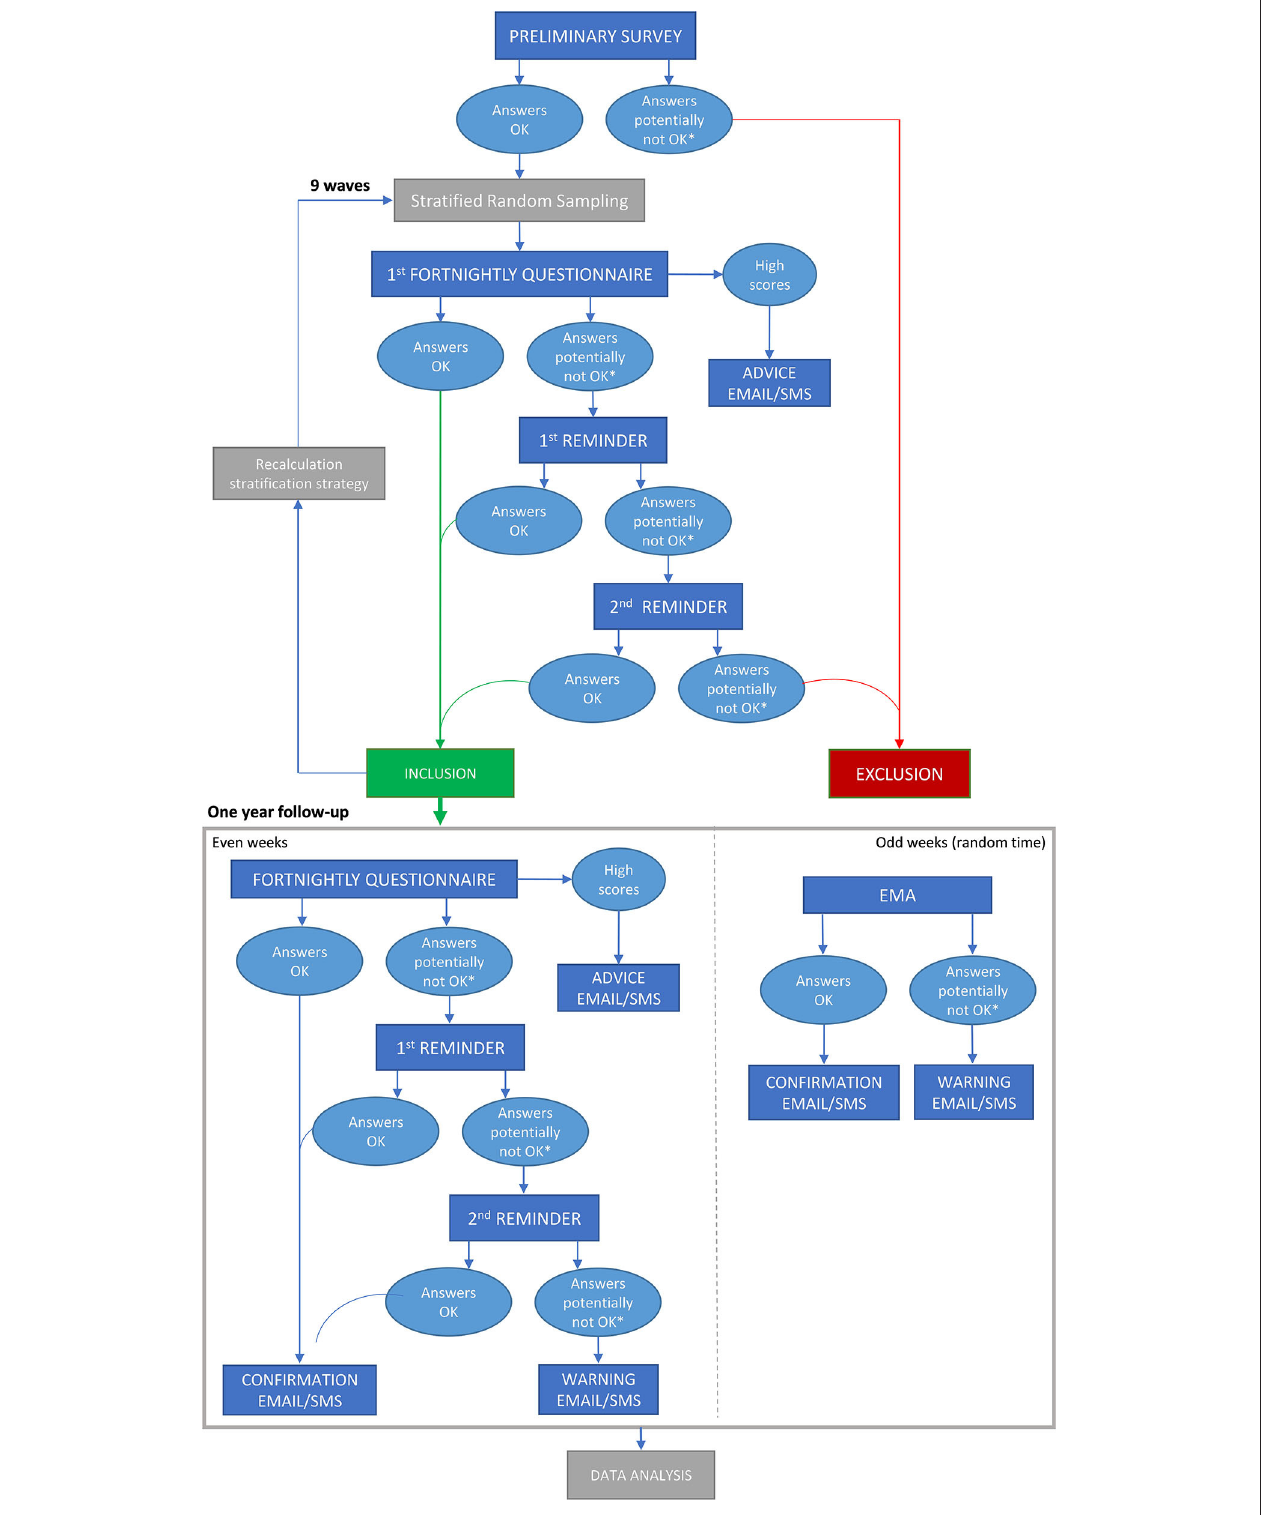
FIGURE 1 | Flowchart of the study. EMA, ecological momentary assessments; SMS, Short Message Service.